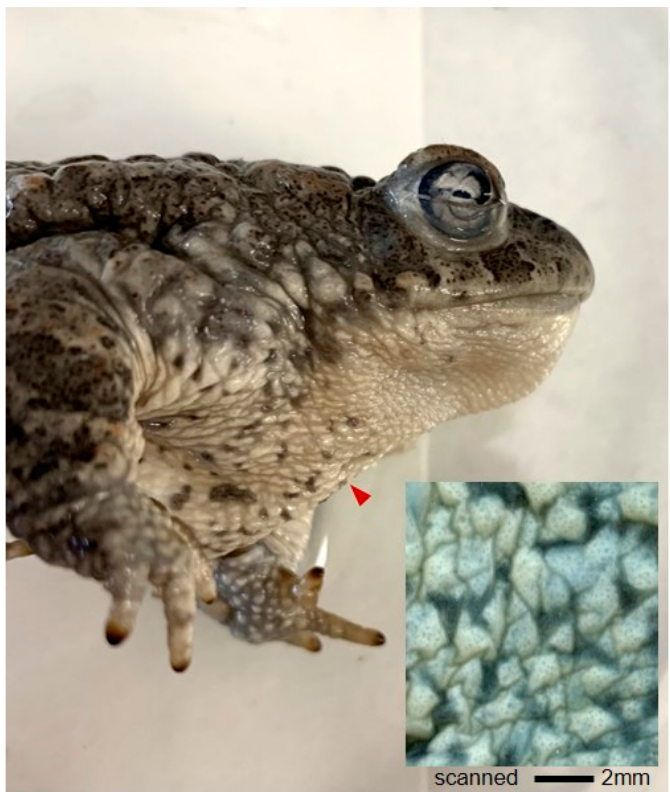
Figure 2. Characteristic aspect of dorsal and ventral tegumentary surfaces and pigmentary pattern. Ventral skin (inset) with smaller cystic serous glands, less relief, and lighter pigment density than on the back, allowing a better binocular observation of the light-reflecting pattern and individual melanophores on a surface view (photos by J.M. López-Cepero).